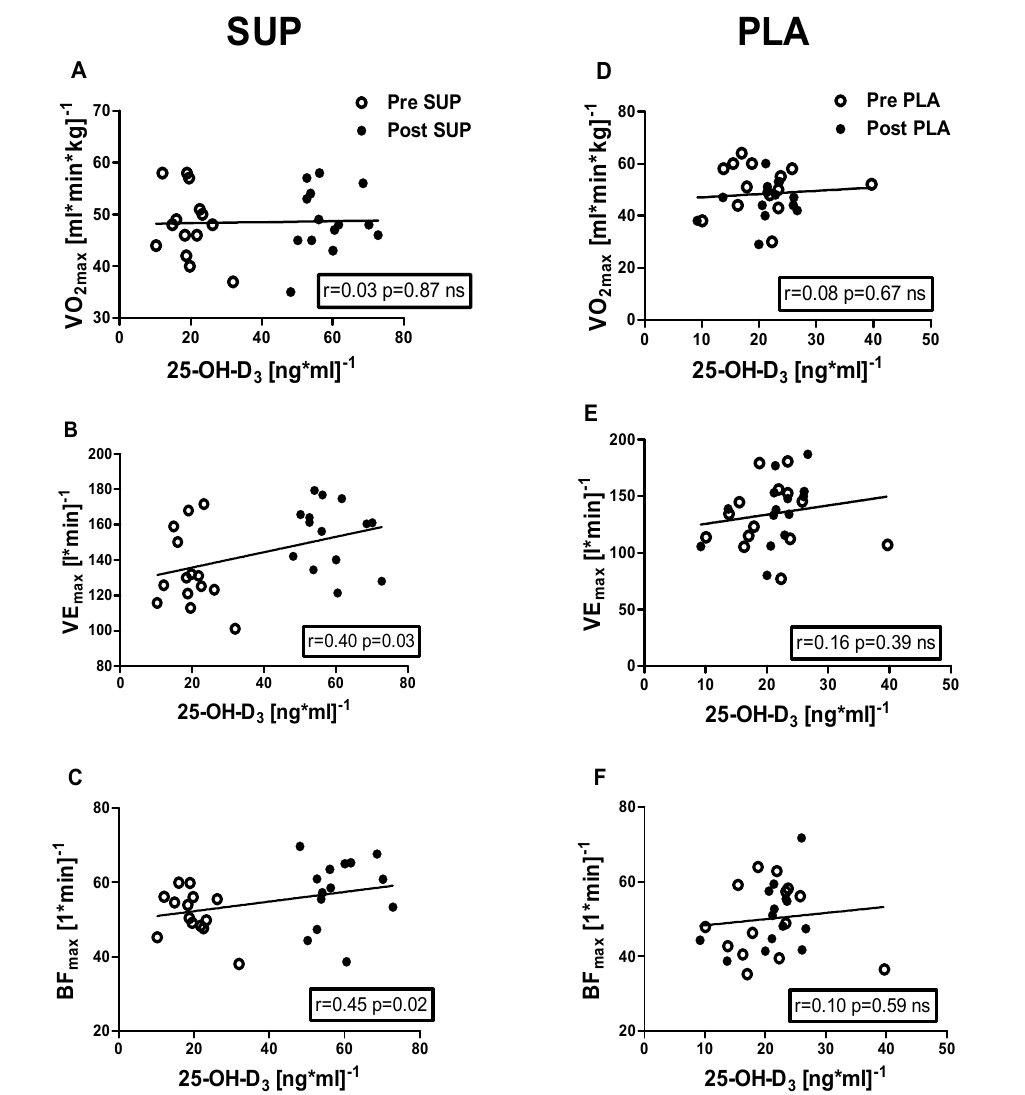
Figure 6. Association between 25-OH-D 3 and VO 2max , VE max , and BF max , of pre- and post-intervention in the SUP and PLA groups. Significant positive correlations between 25-OH-D 3 and VE max ( B ), 25-OH-D 3 , and BF max ( C ) were found in the SUP group. Correlations between 25-OH-D 3 and VO 2max ( D ), VE max ( E ), and BF max ( F ) in PLA group were not found. Data are presented as open circles: pre, and closed circles: post SUP or PLA. ns, non- significant.